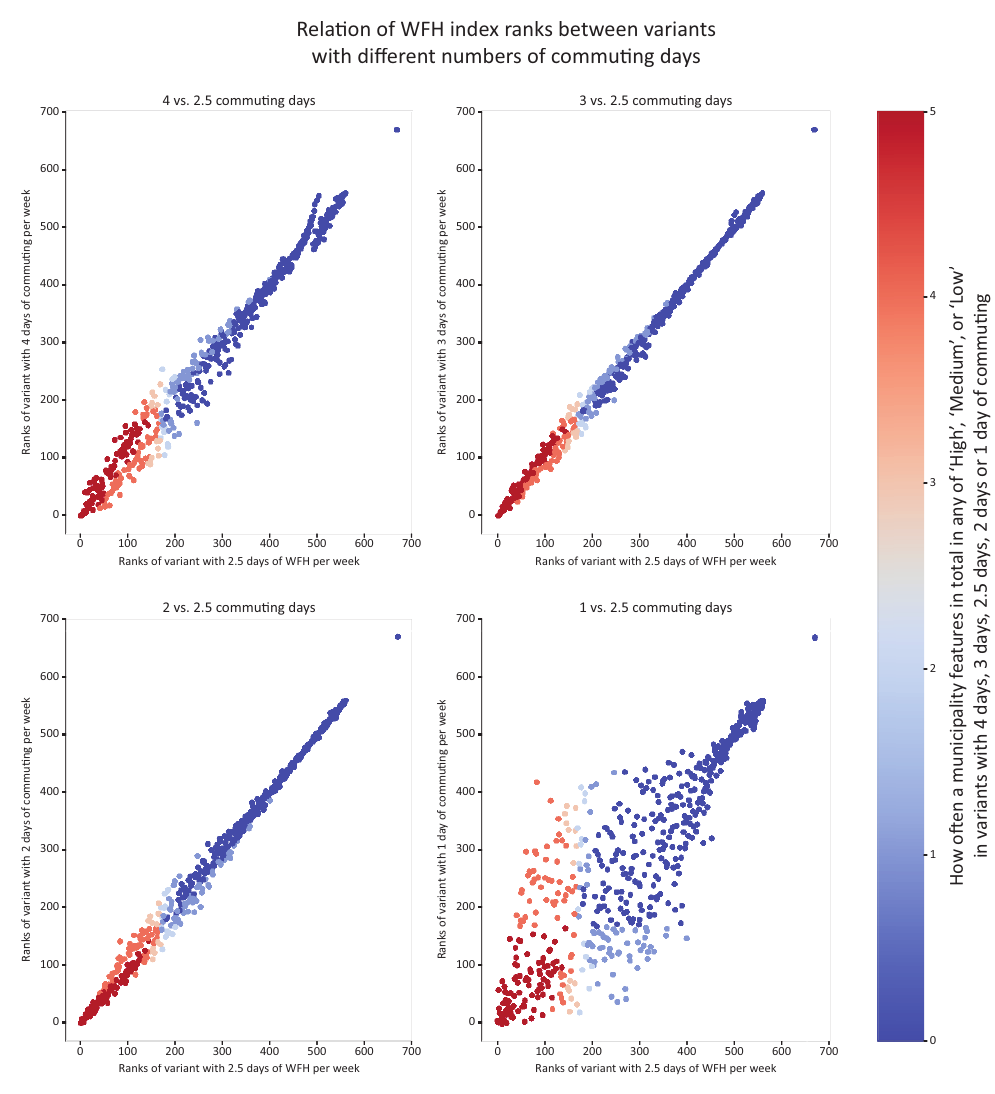
Figure 7. Sensitivity analyses with different 𝛽 values that represent the change from five to fewer commuting